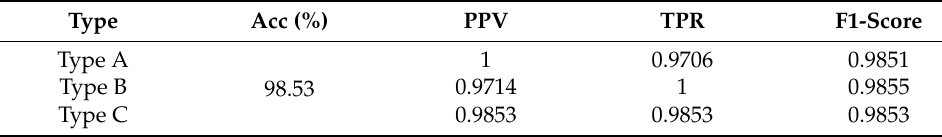
Figure 8. Confusion matrix of ViT-Base/16. Table 2. Sorting results of ViT.